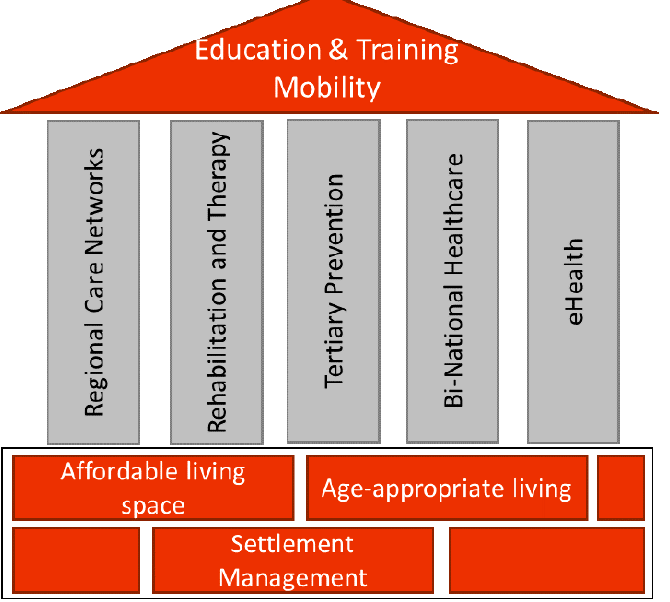
Figure 2: Exemplary model for deployment of a cross-border region for active and healthy